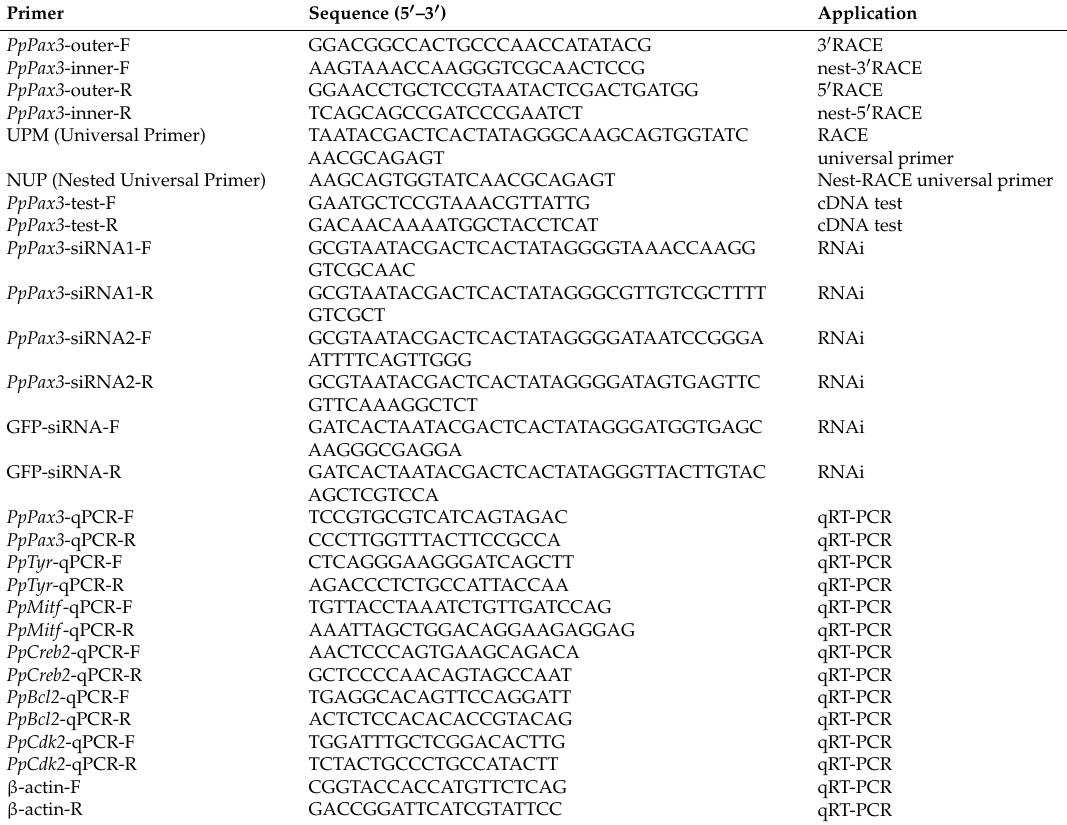
Table 1. Primers used in the